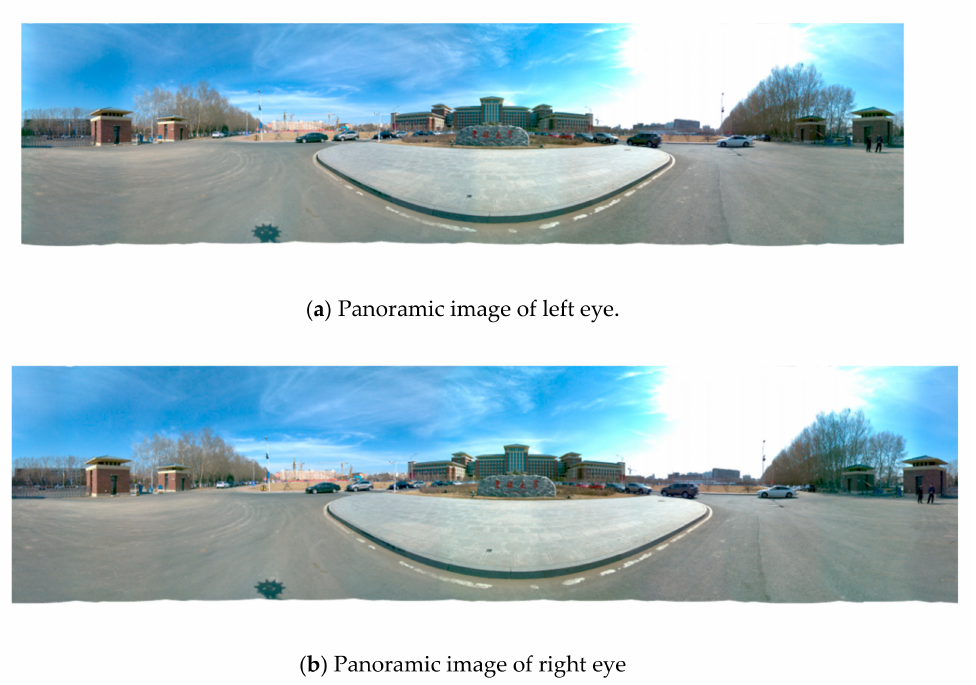
Figure 6. The left ( a ) and right eye ( b ) compose a stereoscopic panorama.